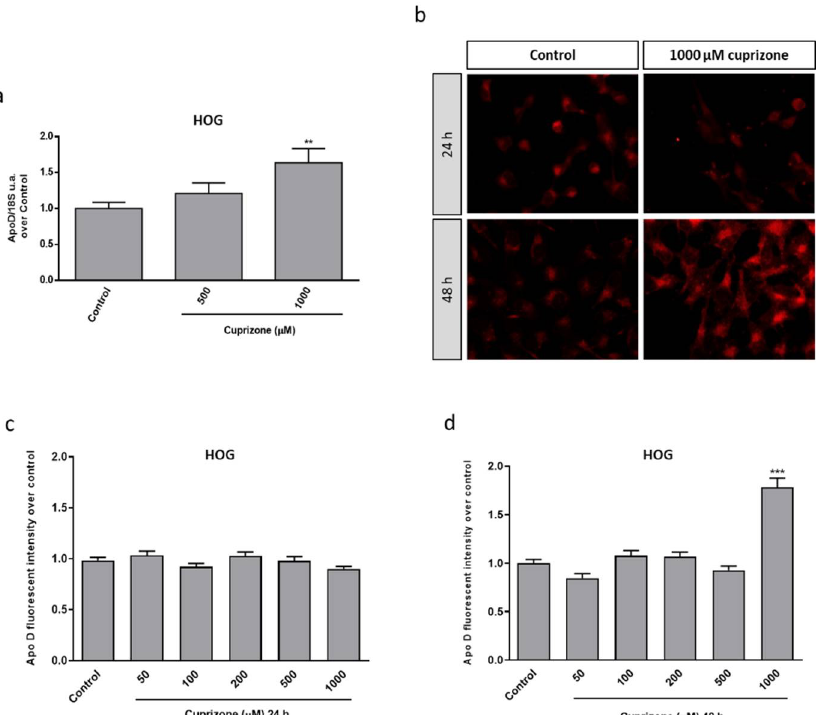
Figure 1. Relative Apo D gene expression in HOG cells treated with 0–1000 µM of CPZ following 24 h. Data represent the quotient between the gene and the expression of the housekeeping gene 18S rRNA. Bars represent the mean ± SEM of all measurements ( n = 6–8) ( a ). Representative fluorescence microscopy images of Apo D levels in HOG cells treated or not with 1000 µM of CPZ during 24 and 48 h. 40× magnification ( b ). Densitometric quantification of Apo D immunocytochemical signal after 24 ( c ) and 48 h ( d ) of treatment with increasing concentrations of CPZ (50 µM–1000 µM) in HOG cells ( n = 6). Bars represent mean density per cell in a 40× field ± SEM (over control). Significant differences were analyzed by a one-way ANOVA followed by post-hoc Tukey’s test. ** p < 0.01, *** p < 0.001 compared with control.